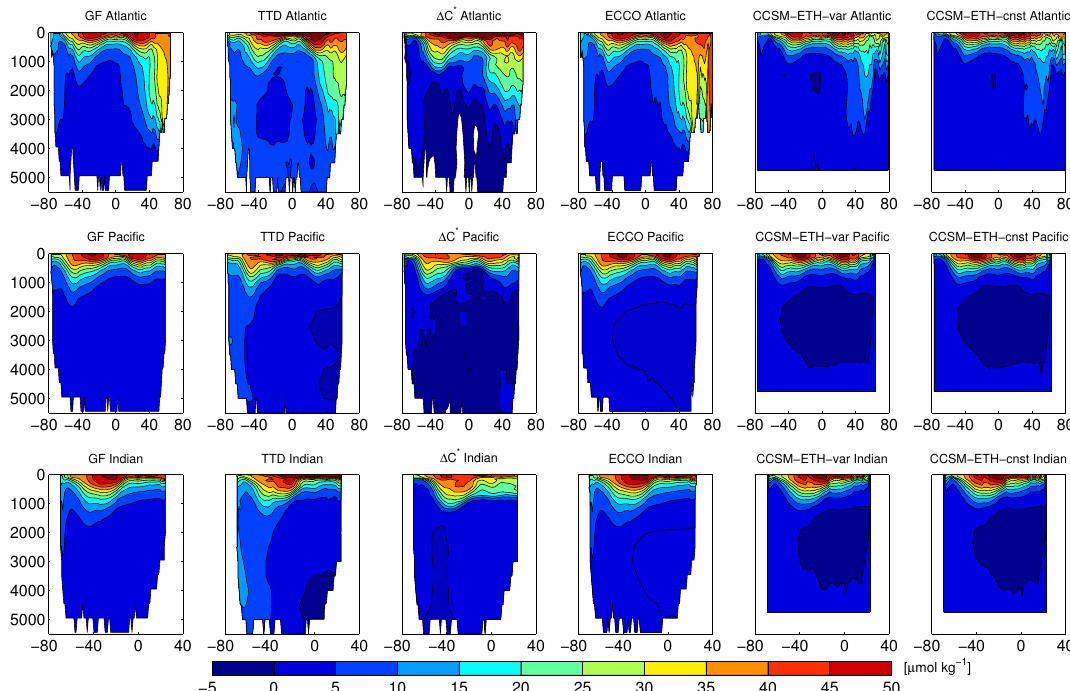
Fig. 3. Zonal mean sections of C ant in 1994 estimated by three data-based methods and three forward ocean model simulations. Top to bottom: Atlantic, Pacific, and Indian oceans; left to right: Green’s function, TTD, 1 C ∗ , ECCO, CCSM-ETH-var, and CCSM-ETH-cnst.